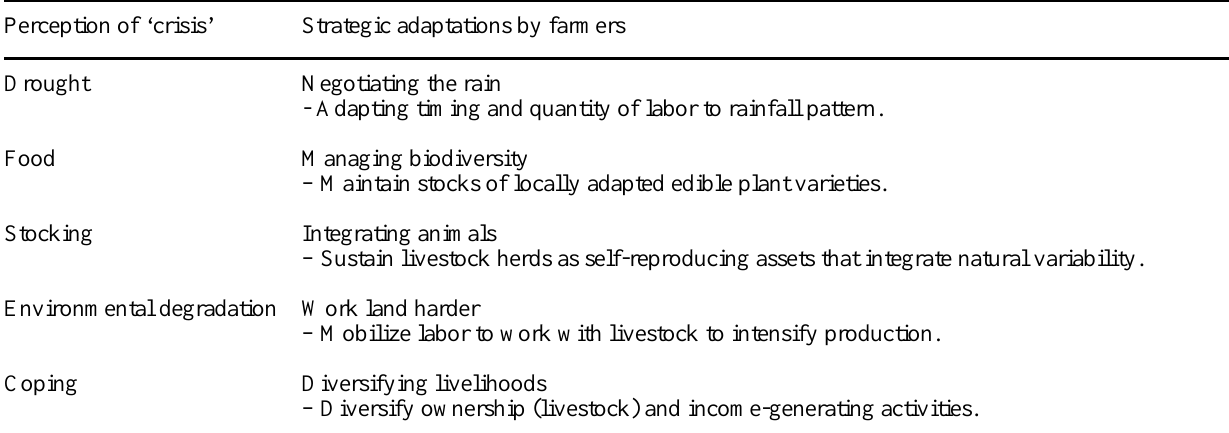
Table 1 . Crises and farmers' strategic adaptations in the Sahel, after Mortimer and Adams (2001). Perception of ‘crisis’ Strategic adaptations by farmers Drought Negotiating the rain - Adapting timing and quantity of labor to rainfall pattern. Food Managing biodiversity – Maintain stocks of locally adapted edible plant varieties. Stocking Integrating animals – Sustain livestock herds as self-reproducing assets that integrate natural